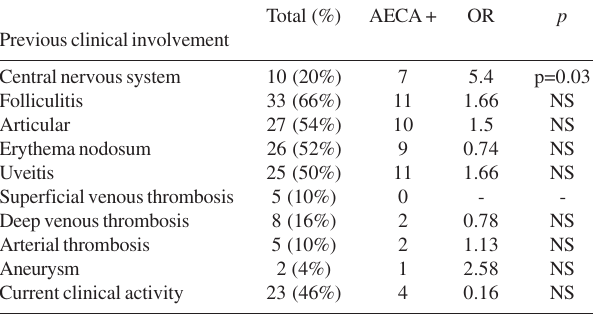
Table 2 - Presence of AECA and correlation with both previous clinical involvement and current clinical disease